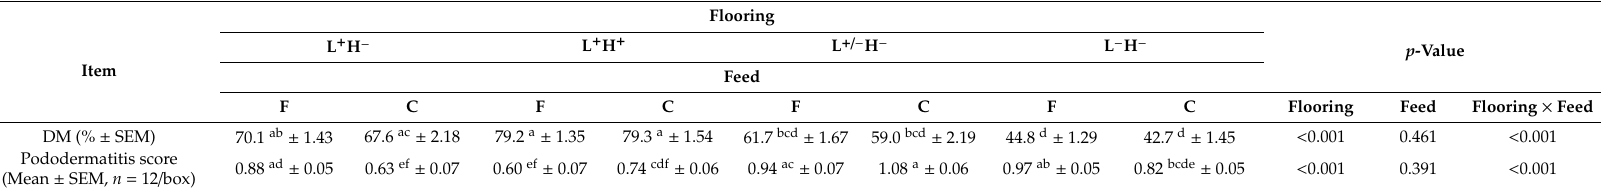
Table 9. Dry matter content (%) in litter and pododermatitis scores of broilers fed di ff erent feed particle sizes and reared on di ff erent floor designs at d 36 /